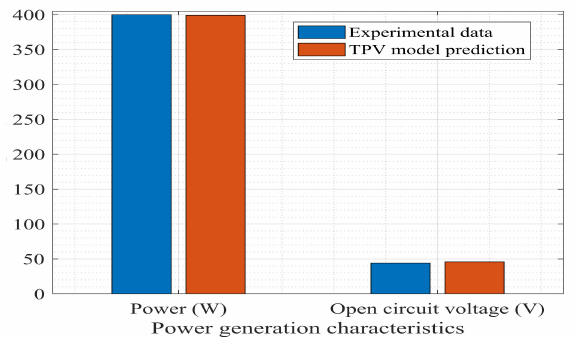
Figure 3. Comparison between predicted and experimental values of power generation